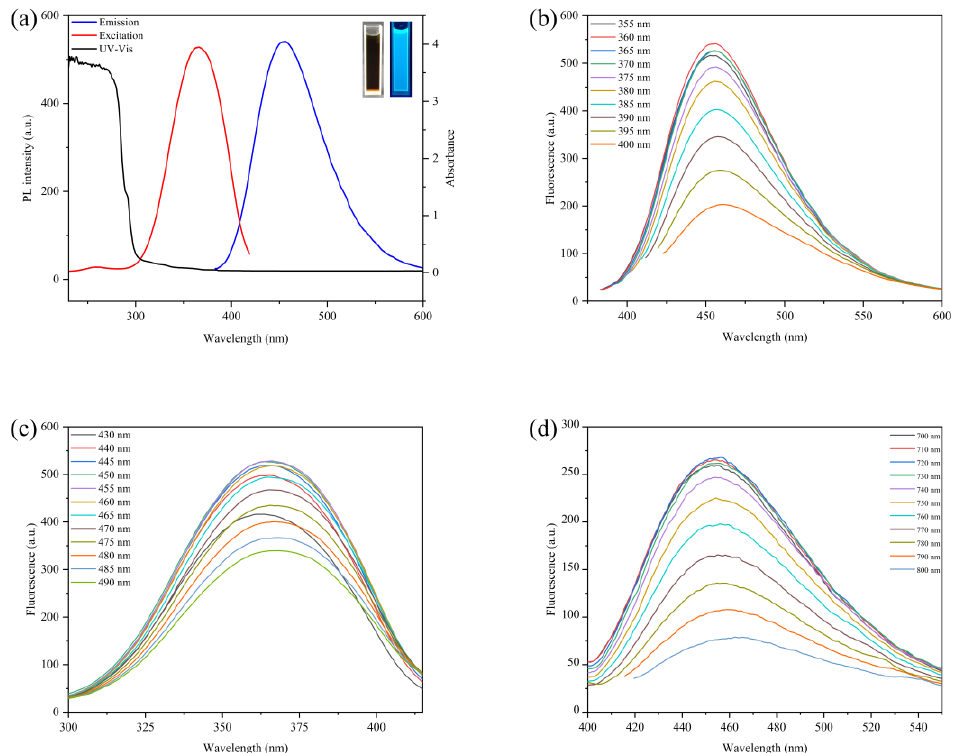
Figure 3. ( a ) UV-Vis absorption (black line), fluorescence excitation (red line) and emission (blue line) spectrum of CDs. Insets: The fluorescence phenomenon of CDs in cuvette before and after irradiation at 365 nm UV. Fluorescence spectra of CDs at different wavelengths: ( b ) under different excitation wavelengths; ( c ) under different emission wavelengths. ( d ) Upconversion spectra of carbon dots under different excitation wavelengths.